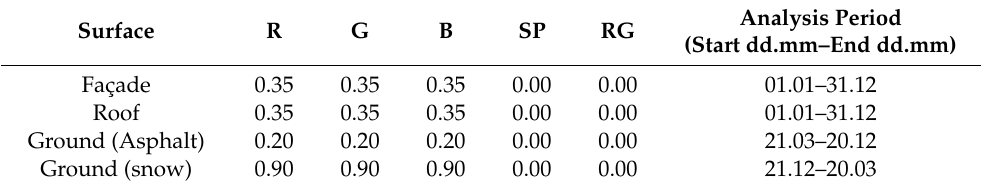
Table 4. Radiance parameters for the materials used in the solar irradiation